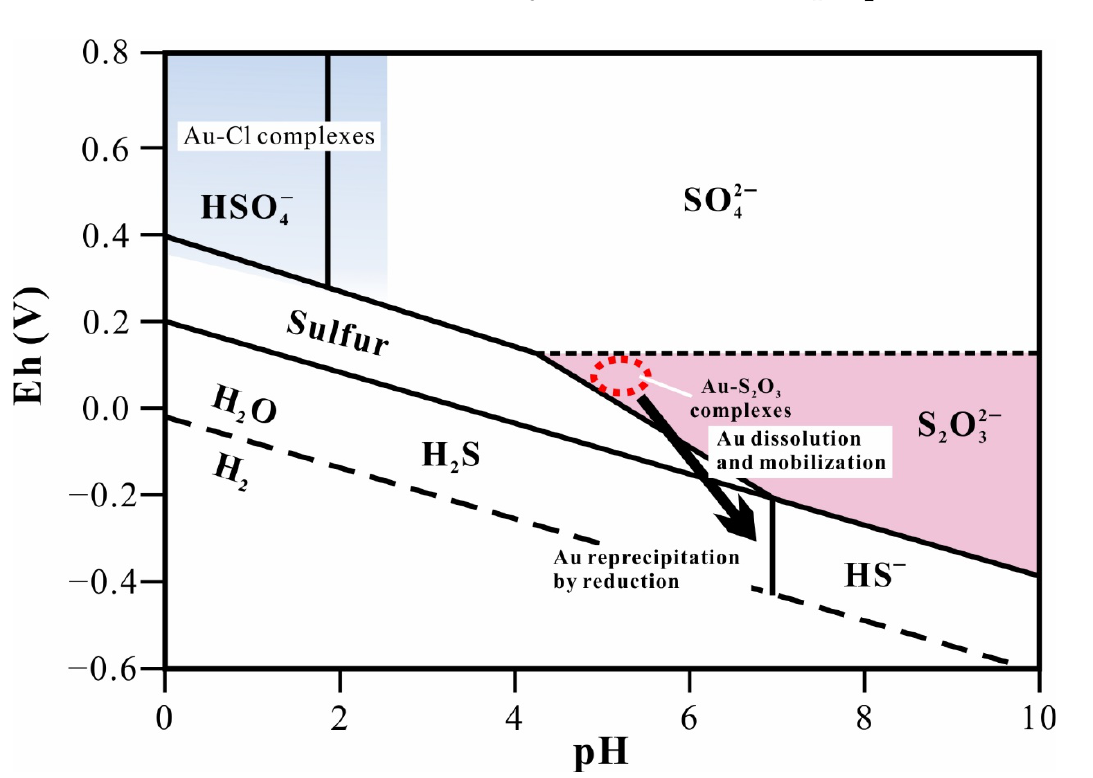
Figure 10. Schematic pH–Eh diagram for 5 × 10 − 3 molar dissolved sulfur at 25 °C (reproduced from Craw et al. [8] with permission of Taylor & Francis Ltd.). Metastable thiosulphate ions are produced from the oxidation of primary pyrite under weakly acidic conditions (red dashed domain). Gold is transported as thiosulphate complexes in the oxidation zone and precipitated in the supergene enrichment zone by reduction (black arrow). In contrast, gold chloride complexes are stable only in the low-pH, high-Eh, and Cl-rich conditions (top left gray